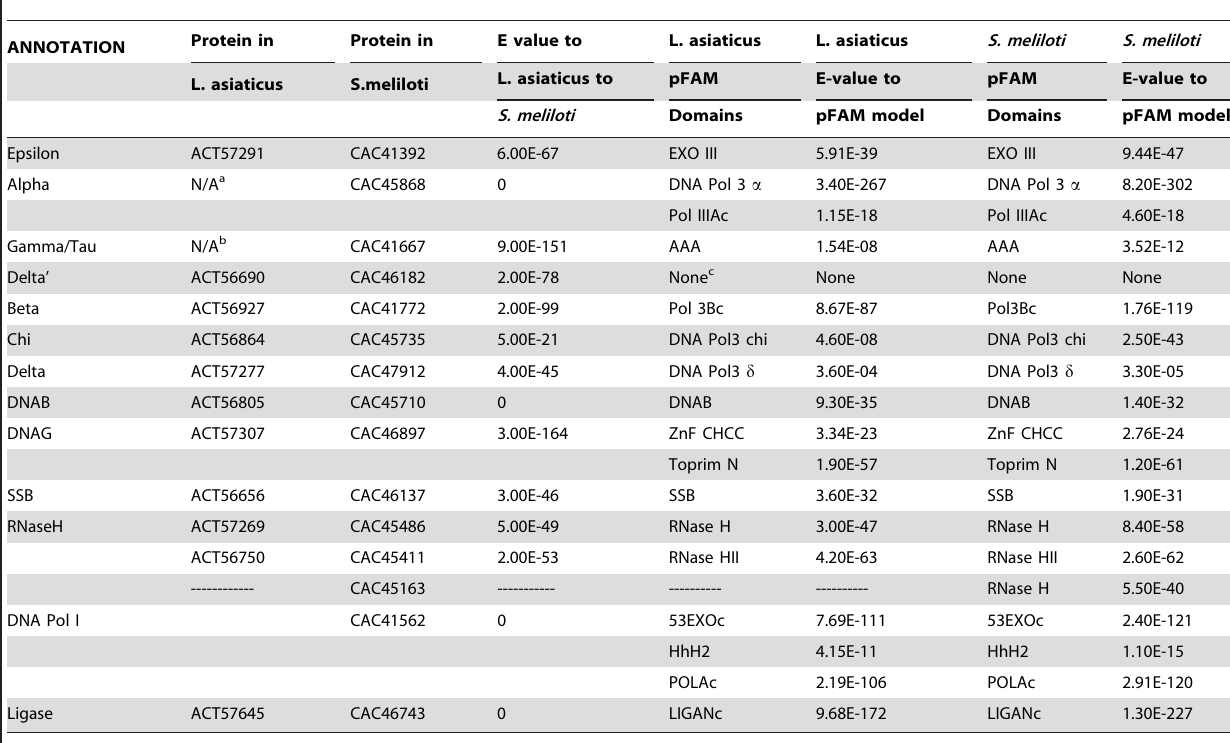
Table 1. Proteins involved in the DNA Polymerase III replication complex in ‘ Ca . Liberibacter asiaticus’ and Sinorhizobium meliloti .